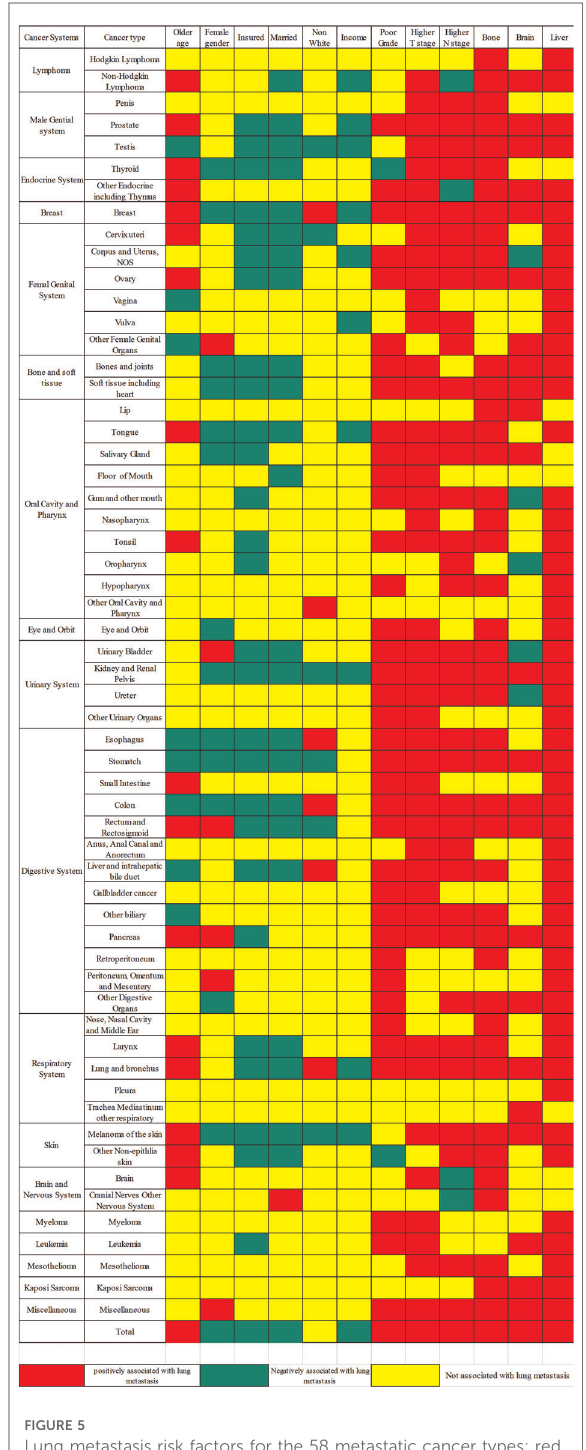
FIGURE 5 Lung metastasis risk factors for the 58 metastatic cancer types; red and green show risk and protective factors, respectively, in the LM of cancers, while yellow indicates factors that were not signi fi